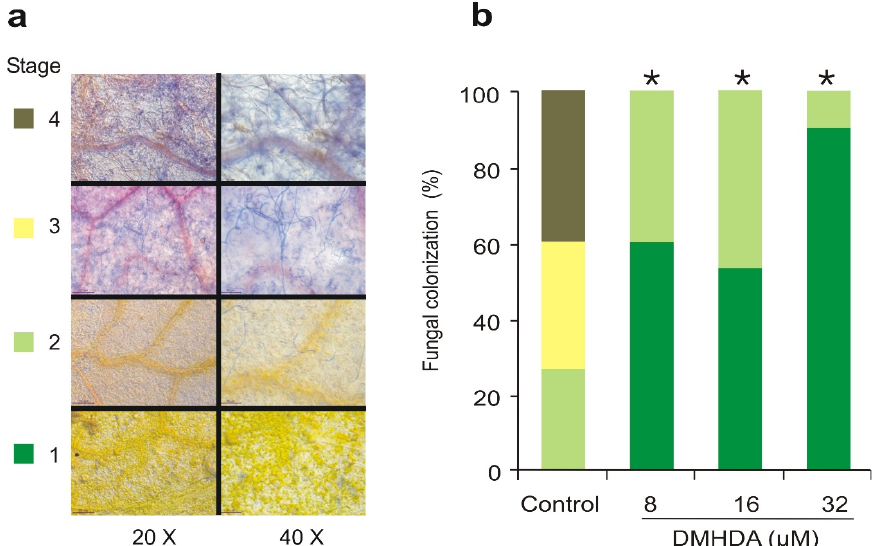
Figure 2. DMHDA promotes the resistance of A. thaliana seedlings against Botrytis cinerea . Leaves of A. thaliana plants were infected with B. cinerea and, five days after inoculation, were stained with trypan blue. Panel ( a ) shows the severity of symptoms considered to classify the colo- nization by B. cinerea in leaves of A. thaliana . Representative examples of infection classes used for quantification of B. cinerea infection. Stage 1, absent or minimal colonization; stage 2, ≤ 50% leaf area colonized by the pathogen; stage 3, ≤ 75% leaf area colonized by the pathogen, presence of conidio- phores; stage 4, >75% leaf area colonized by the pathogen, and production of abundant conidio- phores. Representative photographs from a Leica DFC450 C microscope at 20X and 40X objectives. Panel ( b ) shows fungal colonization of plants grown in 0.2× MS medium supplied with 0, 8, 16, and 32 µM DMHDA and infected with B. cinerea . Three days after inoculation, 50 leaves per treatment were stained with trypan blue and classified according to the severity symptoms shown in Figure 1a. Asterisks (*) indicate statistically significant differences in stages distribution compared to the control (0 µM DMHDA) condition ( χ 2 test; p < 0.05).